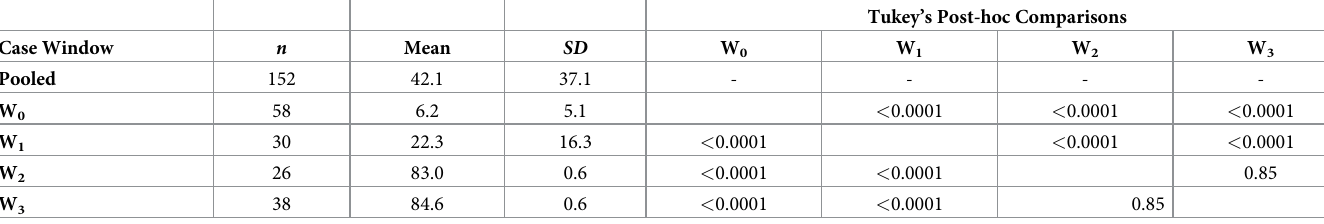
Table 3. One-way analysis of variance of the stringency index score by case window, Nigeria.